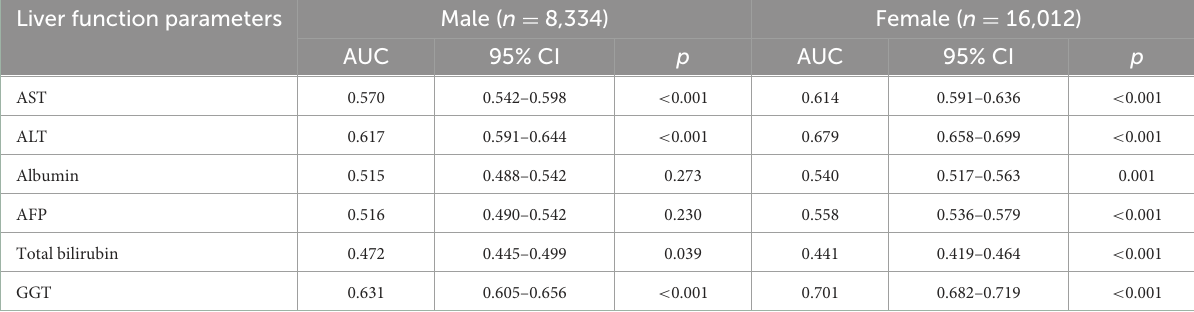
TABLE 4 Area under curve of liver function parameters for incident DM of different sex. Liver function